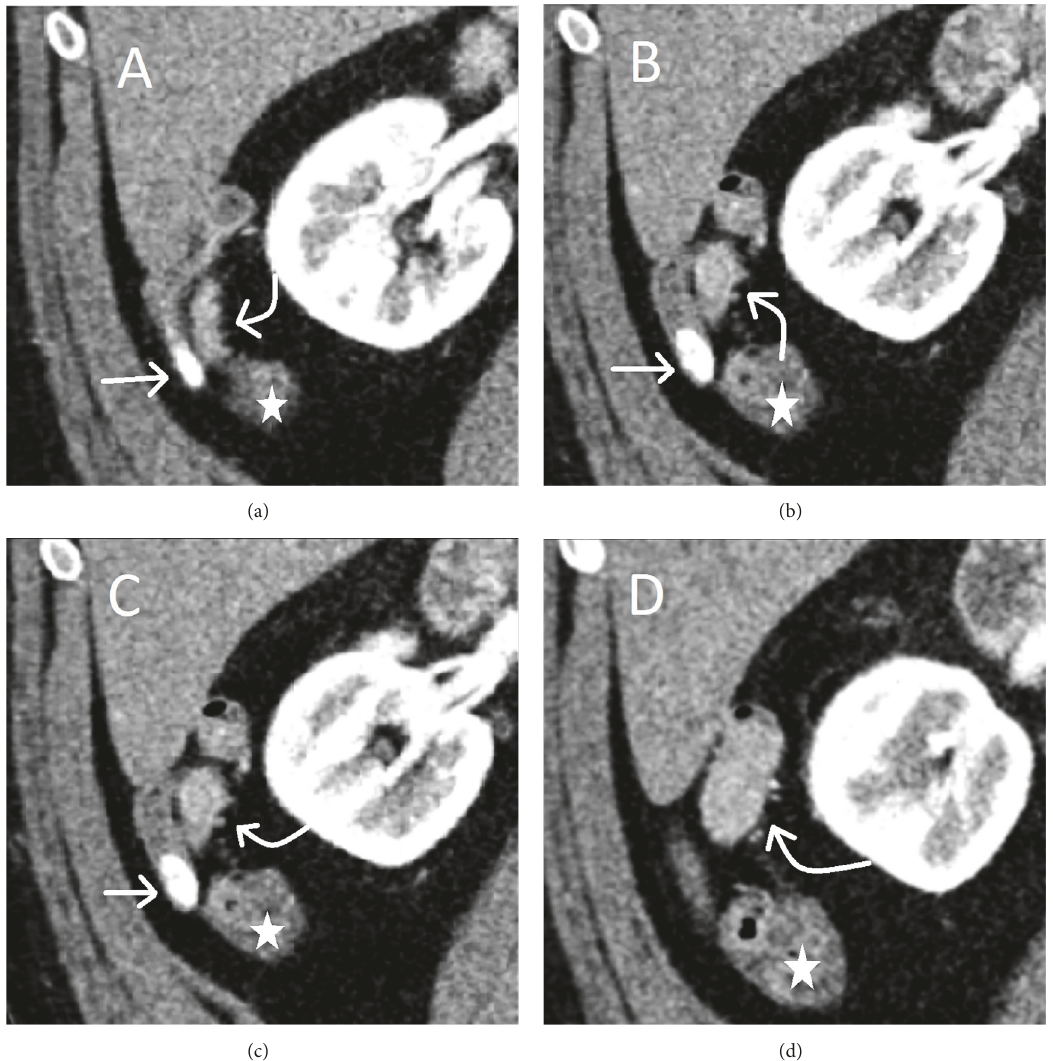
Figure 1: Coronal image from a contrast enhanced CT shows the appendiceal mass. At the widest portion (D) the appendix measured 16 mm in diameter. Cecum (star). Appendicolith at the tip of appendix (straight arrow). Enhancing appendiceal mass concerning mucinous tumor of the appendix (curved